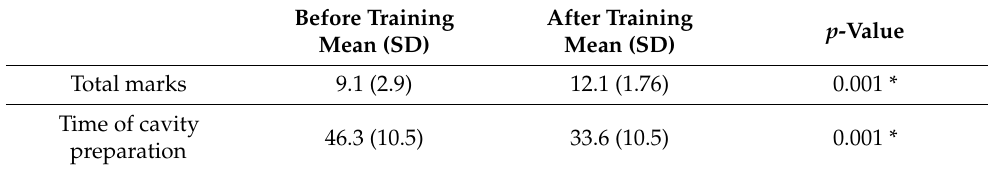
Table 2. Mean of the students’ total marks and time of cavity before and after HVRS training. Before Training